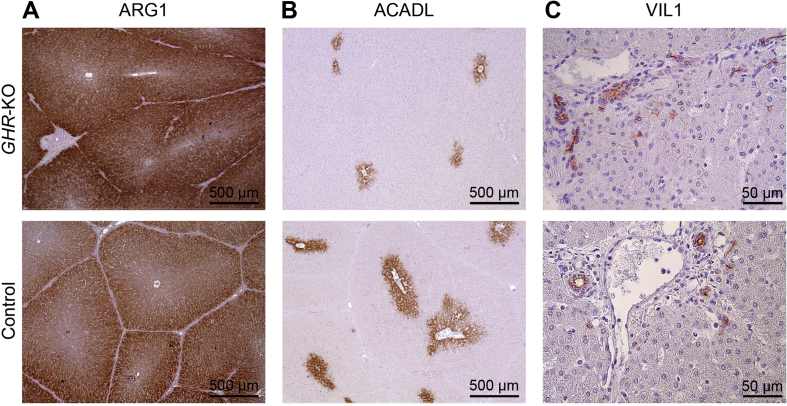
Immunohistochemical localization of arginase 1 (ARG1; A), acyl-CoA dehydrogenase long chain (ACADL; B), and villin 1 (VIL1; C) in liver sections from GHR-KO and control pigs.